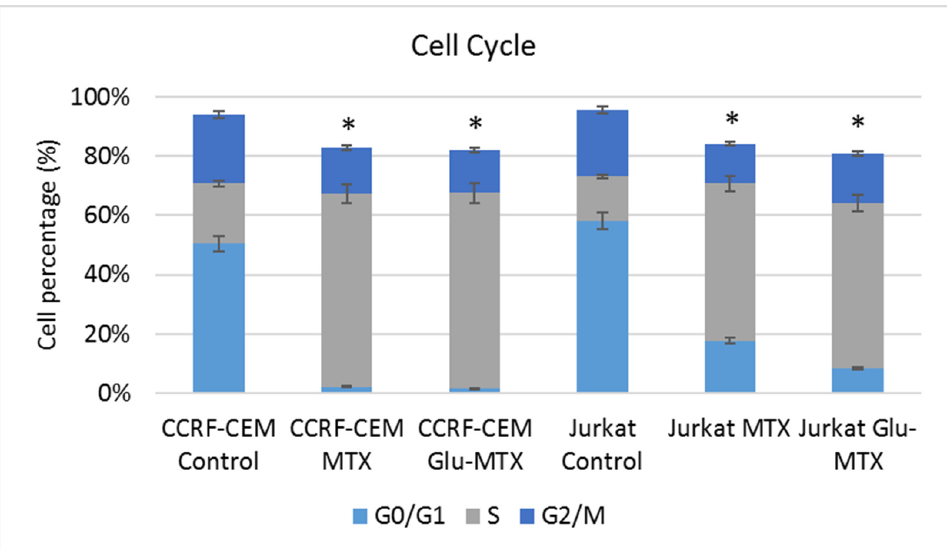
Figure 7. Comparative analysis between MTX and Glu–MTX-treated CCRF–CEM and Jurkat cells G0/G1, S, and G2/M phases. The statistical analysis of differences between control and treated samples was performed using ANOVA Kruskal–Wallis test. * p < 0.05 was indicated as statistical significance, comparing MTX and Glu–MTX-treated cells with control.